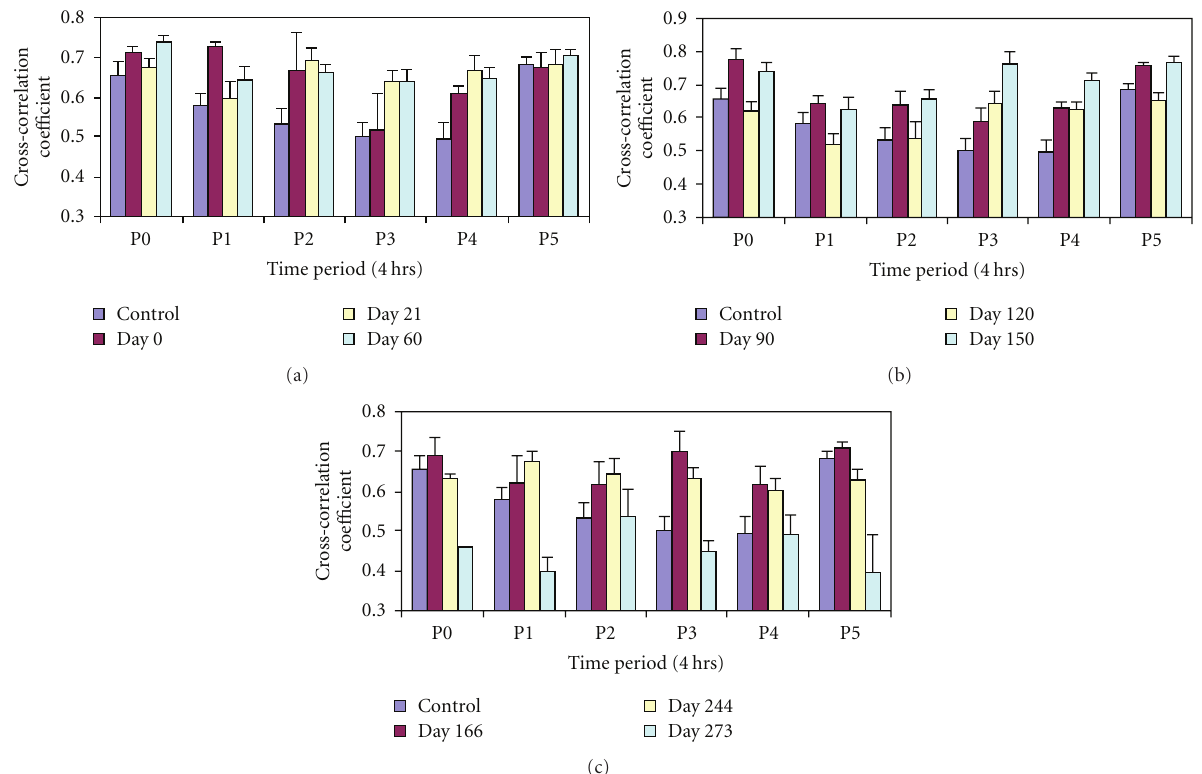
Figure 4: Graph showing circadian variations of cross-correlation coe ffi cients (Xcorr) of blood pressure and heart rate in six periods P0–P5 at (a) 0–60 days (b) 90–150 (c) 166–273 days of diabetic conversion. The prediabetic control values were taken from n14 to n1 days. Values are mean ± SEM. ∗ P < .